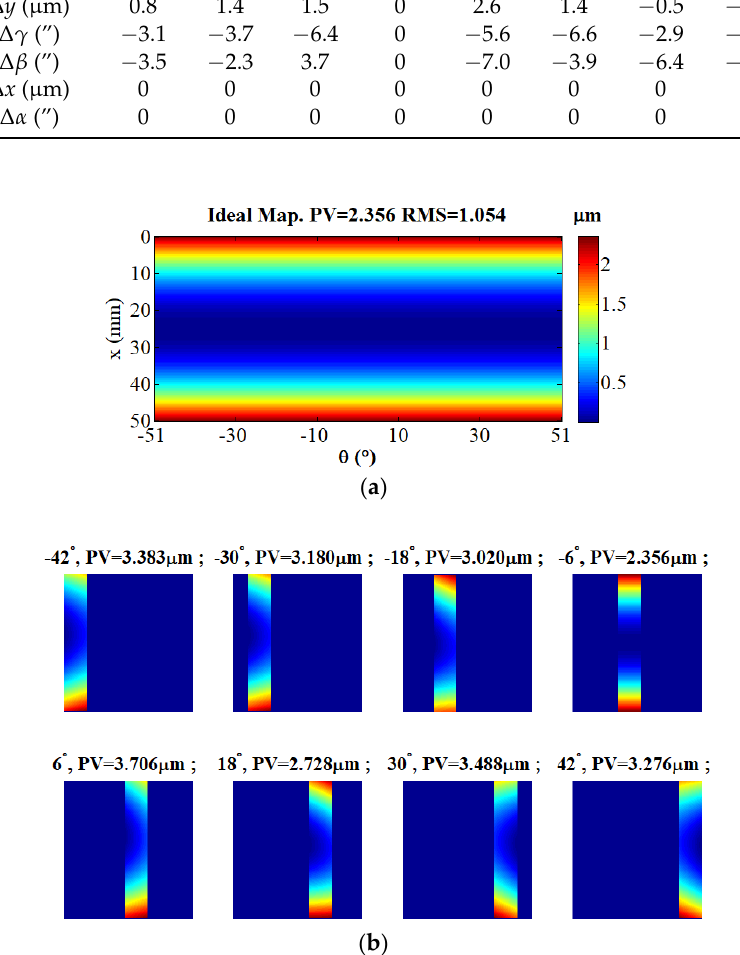
Figure 3. ( a ) The simulation of the proposed method. An ideal cylindrical surface was built and ( b ) eight sub-apertures were segmented to cover the whole surface and each sub-aperture was attached with some position errors.